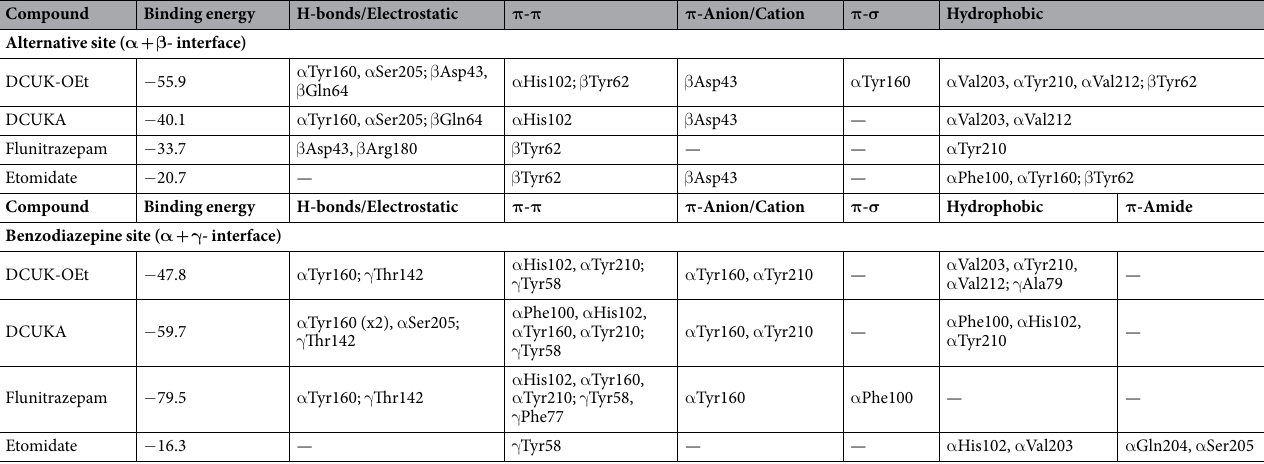
Table 4. Docking binding energies and interactions at GABA A receptor sites. Summary of the binding energies and non-bond interactions of the top scoring predicted binding orientations for each compound docked into the homology model of the benzodiazepine binding site at the α + γ - subunit interface or the “Alternative” binding site at the α + β - subunit interface of the human GABA A receptor shown in Fig. 2 and in Supplementary Fig. S4. Binding orientations were predicted using the Discovery Studio flexible docking protocol and energies were calculated using the distance-dependent dielectric model, as outlined in the